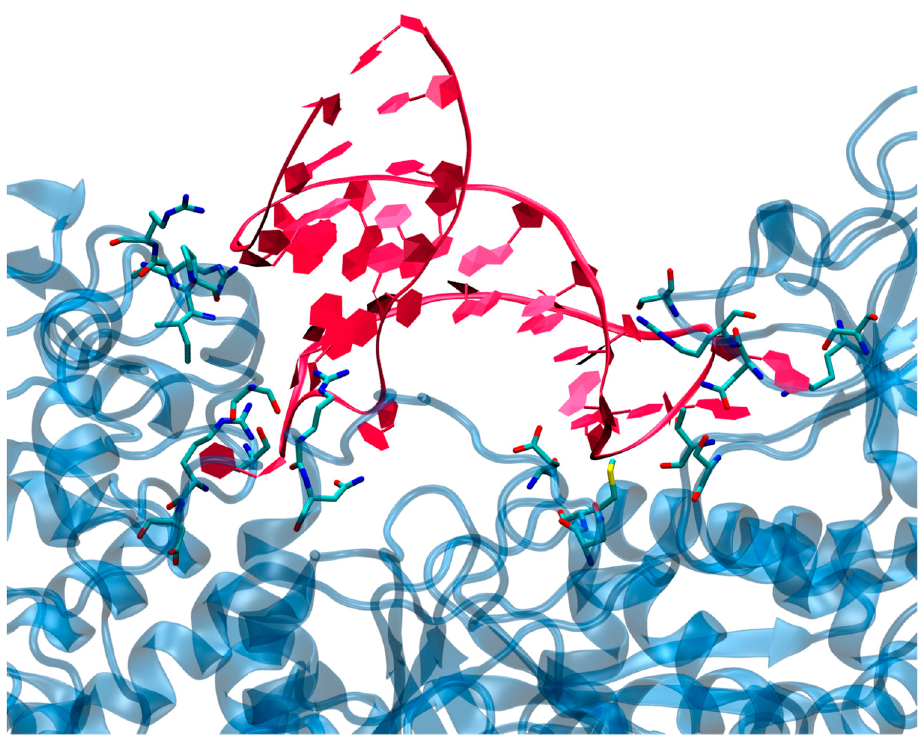
Figure 3 . A zoom on a representative snapshot of the MD simulation of the IRP/IRE complex showing the contact region and highlighting the interacting residues.